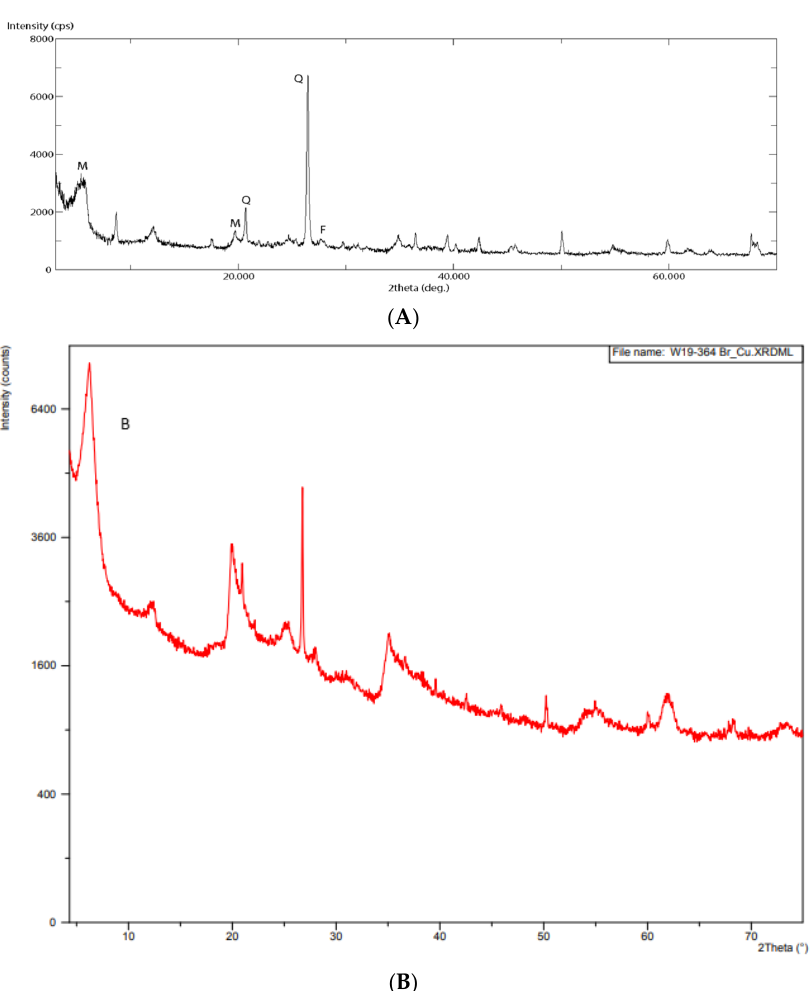
Figure 2. Comparison of X-ray diffraction (XRD) patterns ( A ). The XRD patterns of raw montmorillonite and ( B ). The XRD patterns of modified montmorillonite with ionic liquids.